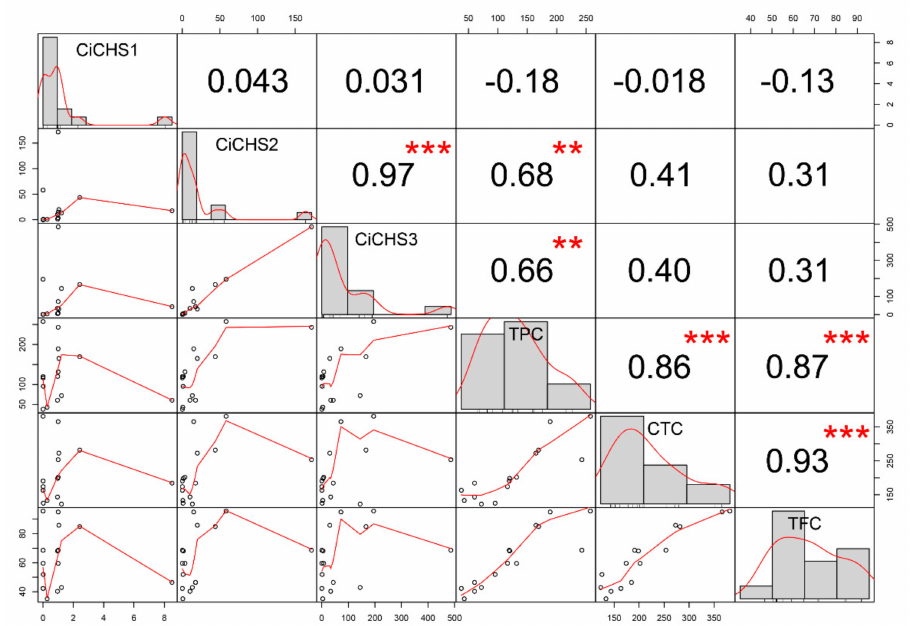
Figure 6. Correlation coe ffi cient of phenolic content and gene expression during pecan kernel development. The distribution of gene expression values and phenolics component contents are shown on the diagonal. To the bottom left are the bivariate scatter plots with best fit lines displayed. Correlation coe ffi cients are shown above the diagonal. “***” and “**” denote significance with p values of 0.001 and 0.01,